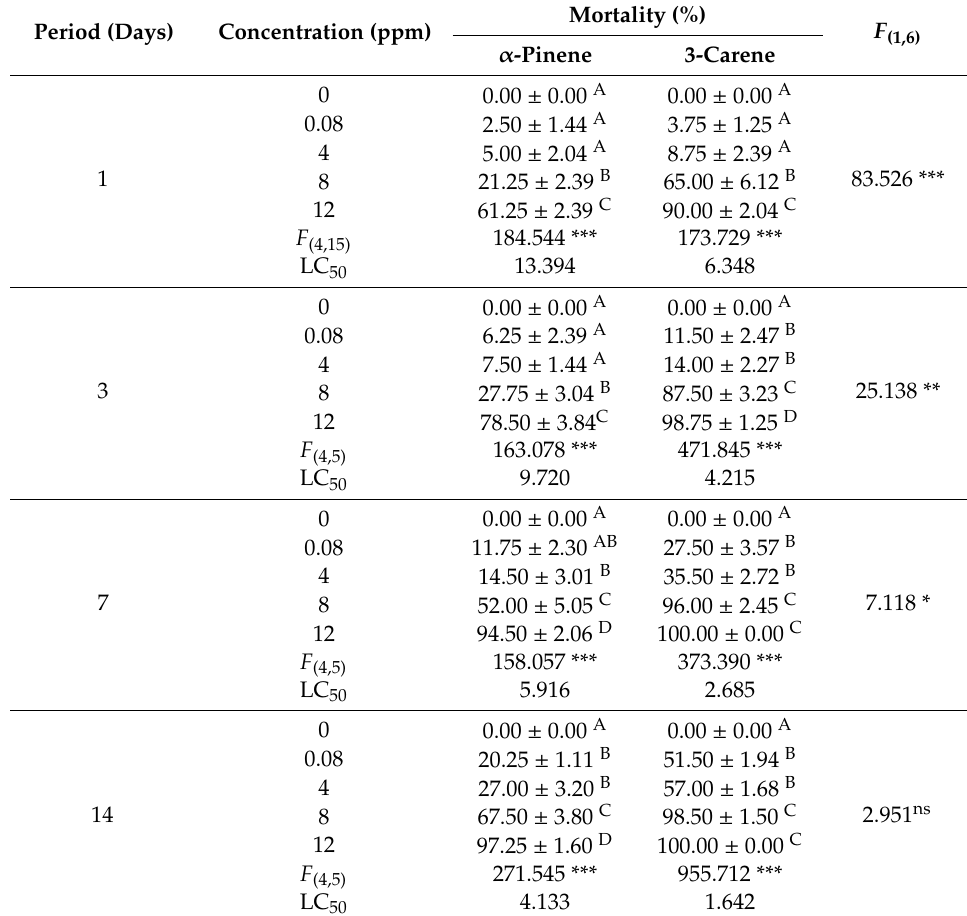
Table 2. Cumulative mortality of Sitophilus zeamais due to treatment of stored maize with α -pinene and 3-carene by